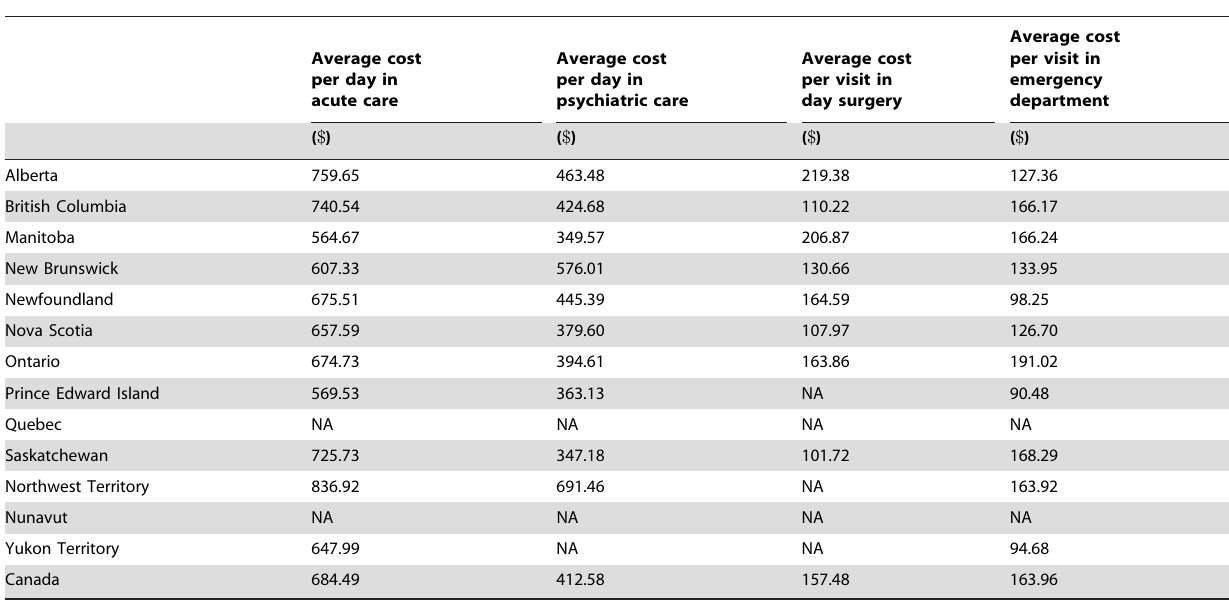
Table 1. Average cost per day/visit by expense type on a provincial/territorial and national level for Canada,